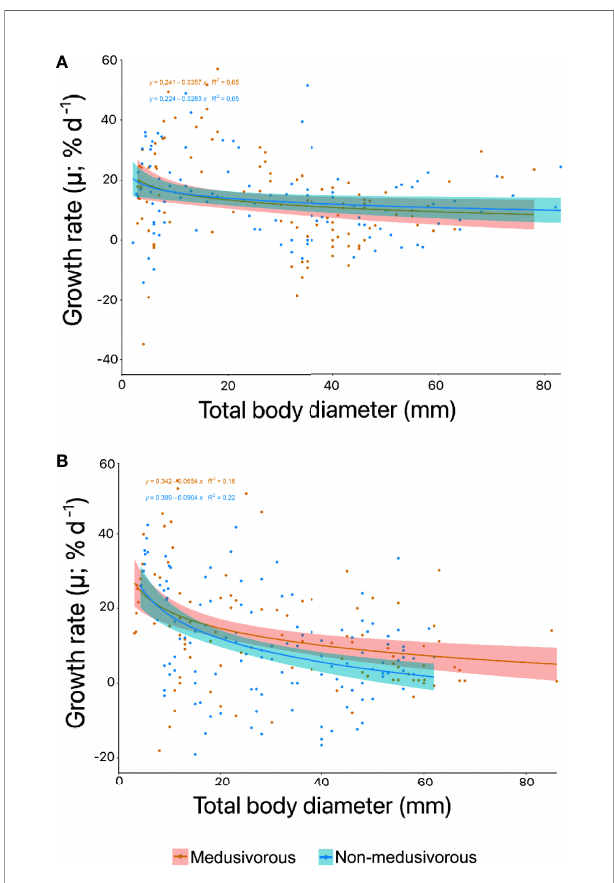
FIGURE 6 | Instantaneous growth rate (% d -1 ) for the successful food regimens for Pelagia noctiluca in (A) fi rst generation and (B) second generation. The decrease in growth rate with total body diameter (TBD) (solid line) represents a power relationship according to positive instantaneous growth rates. The shaded area indicates 95% con fi dence limits. Food regimens: Culture 3, medusivorous diet (presence of Aurelia sp.) and Culture 4, non-medusivorous diet (absence of Aurelia